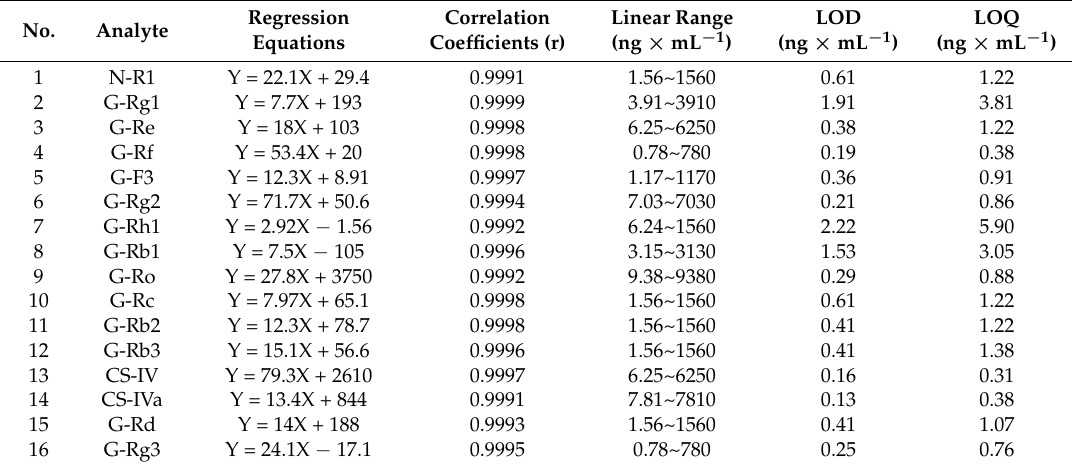
Table 4. The regression equations, linear range, limit of detection (LOD), and limit of quantification (LOQ) of the 16 analytes.